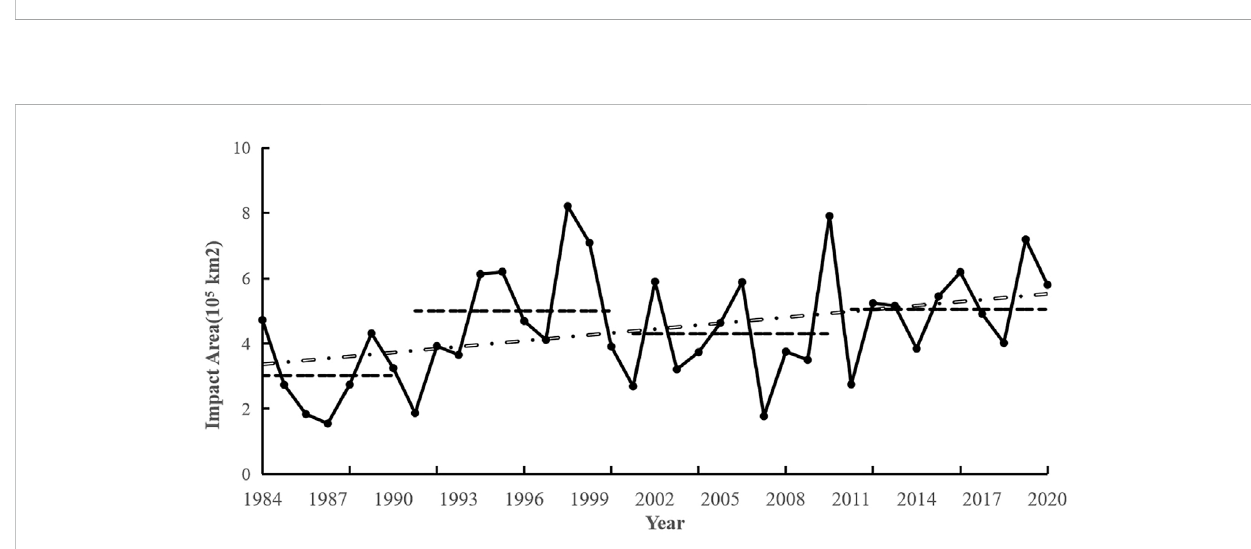
Area impacted by extreme precipitation events in the Poyang Lake Basin (1984 –